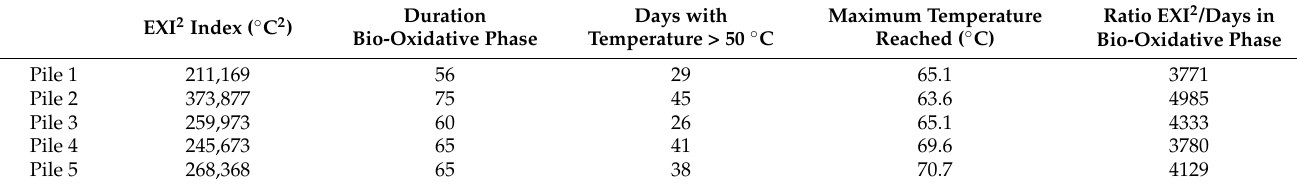
EXI 2 : quadratic exothermic index (quadratic sum of the daily difference between the average temperature of the pile and the ambient temperature). Experiment 1: Piles 1, 2, and 3, constituting only green wastes; Experiment 2: Piles 4 and 5, constituting green wastes and sewage